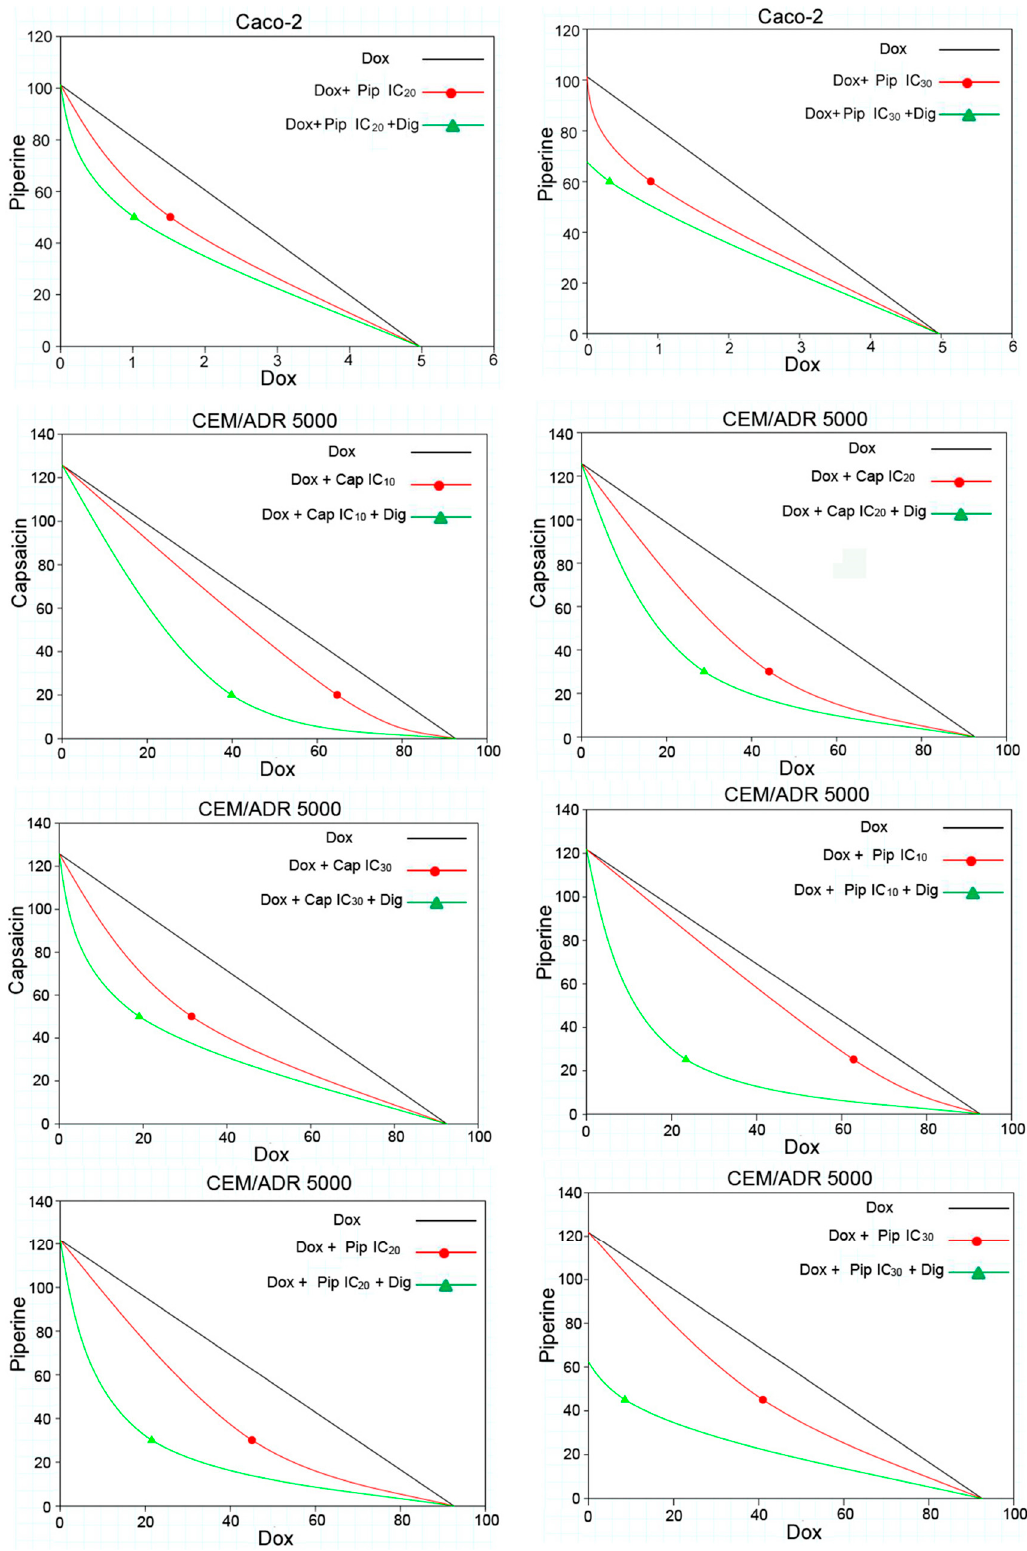
Figure 2. Isobologram analysis of the drugs’ interactions. The IC 50 concentration of doxorubicin is set on the x -axis and the IC 50 of the secondary metabolitesn the y -axis. The line connecting these two points means additivity. Points below the line indicate synergy. Dox—doxorubicin; Cap—capsaicin; Pip—piperine; Dig—digitonine.